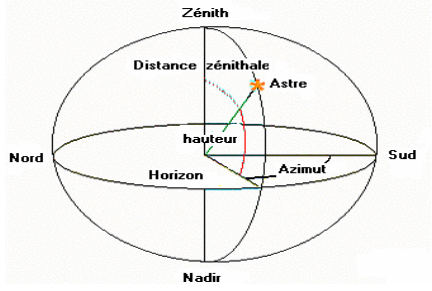
Fig. 2: Horizontal coordinates of the